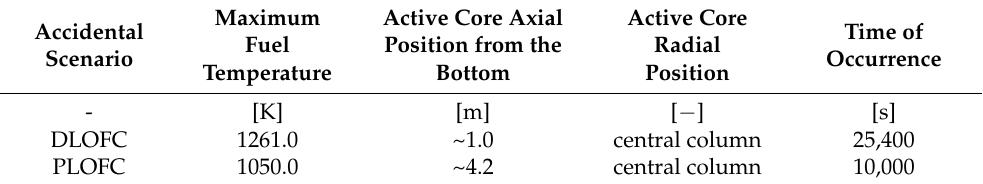
Table 8. Core maximal temperatures for the TeResa core at BOL state for DLOFC and PLOFC accident